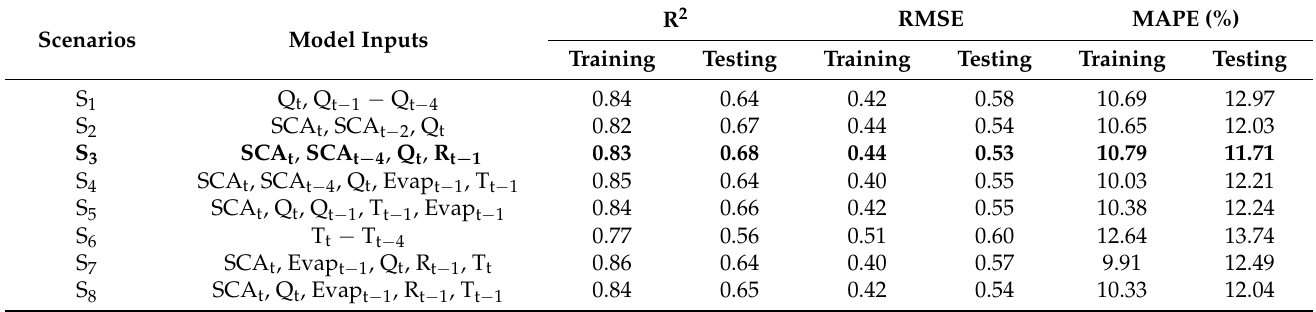
Table 5. Training and testing statistics of the MARS algorithm using various input combinations for the Gilgit River basin.